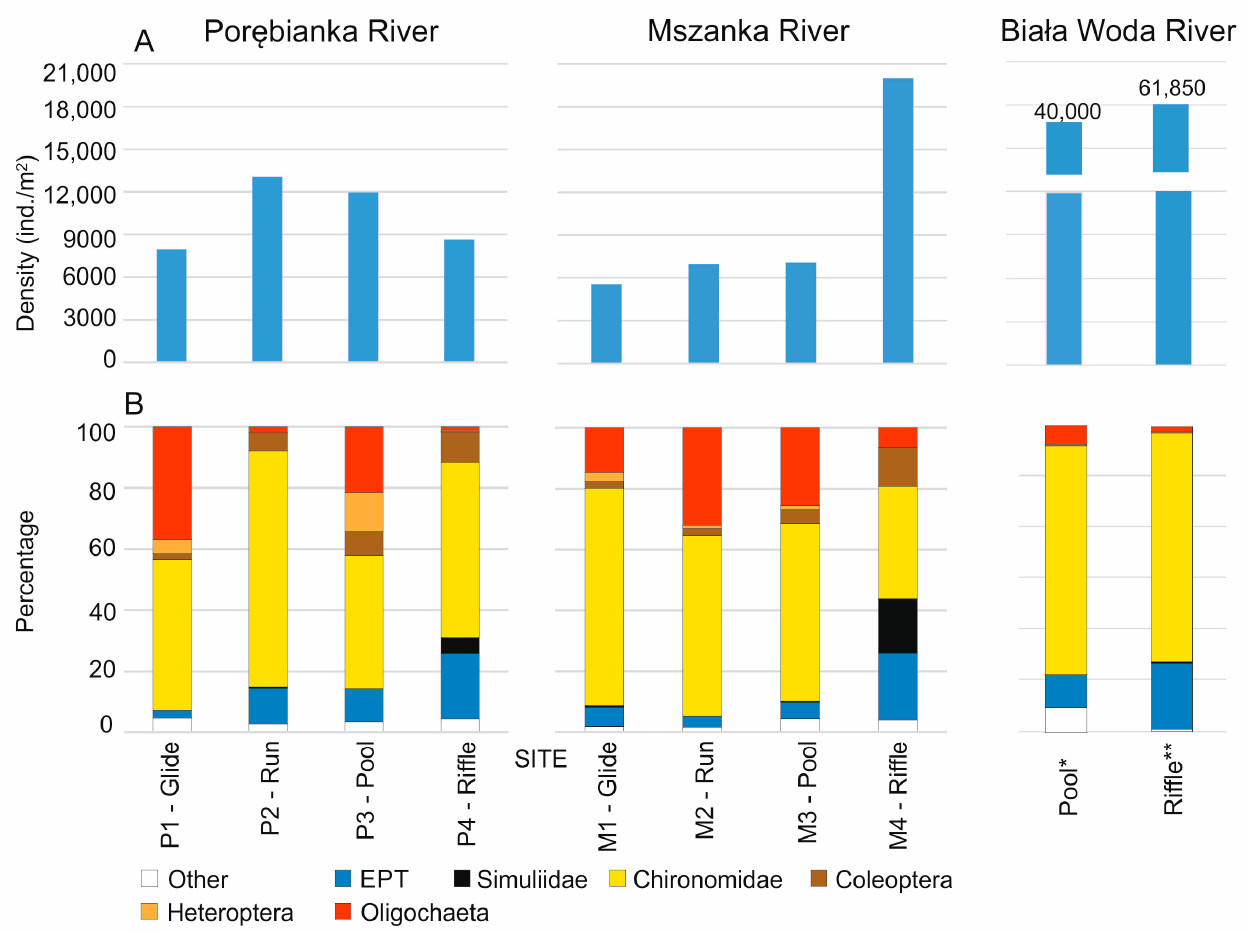
Figure 5. The mean density ( A ) and mean percentage ( B ) of benthic macroinvertebrate groups in the Por˛ebianka and Mszanka rivers (present study) and in the Biała Woda River (according to [28]). In [28] the description of pool and riffle had a wider meaning: * pool—without or with slow current ** riffle—fast current.